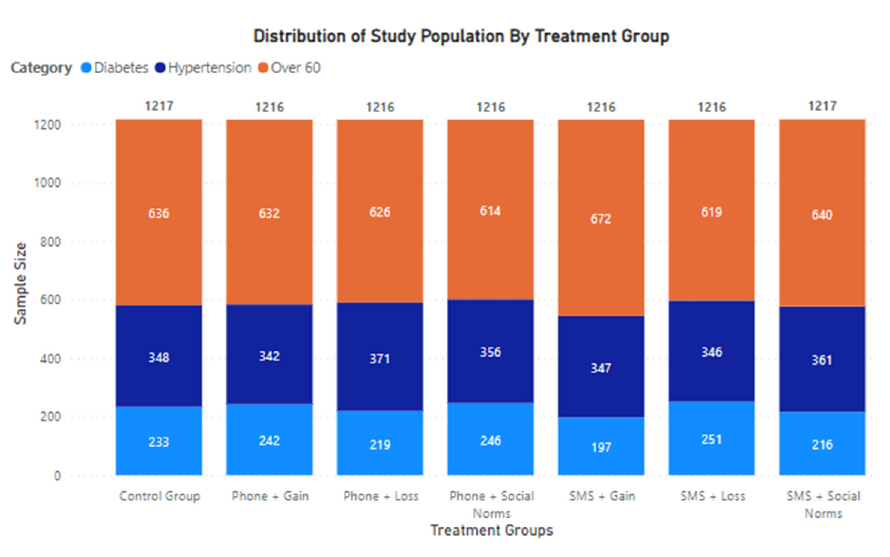
Figure 1. Distribution of treatment groups based on risk category.